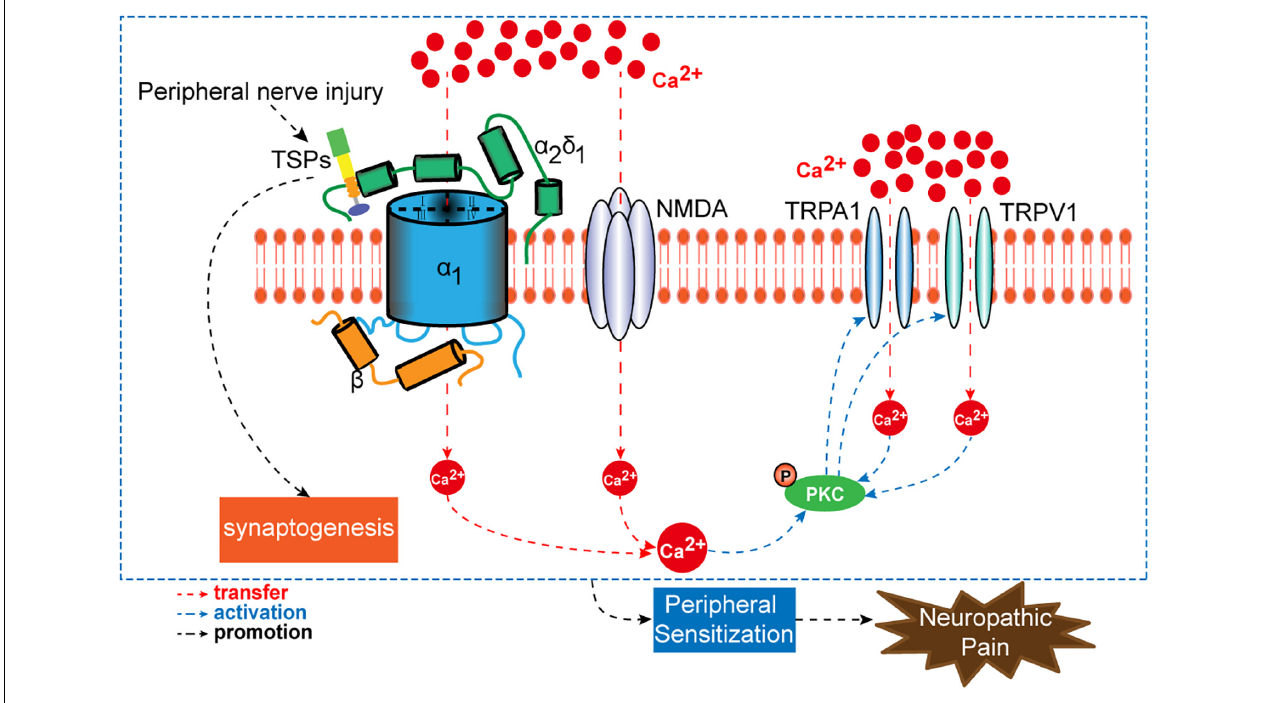
FIGURE 5 | A schematic overview of presynaptic Cav α 2 δ 1 and its interactional targets (TSPs, NMDAR, PKC, TRPA1, and TRPV1) in the process of neuropathic